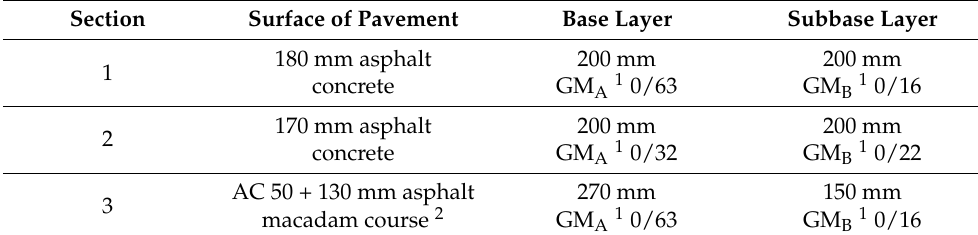
Figure 1. Pavement structure schemes. Table 1. Pavement structures of the monitored